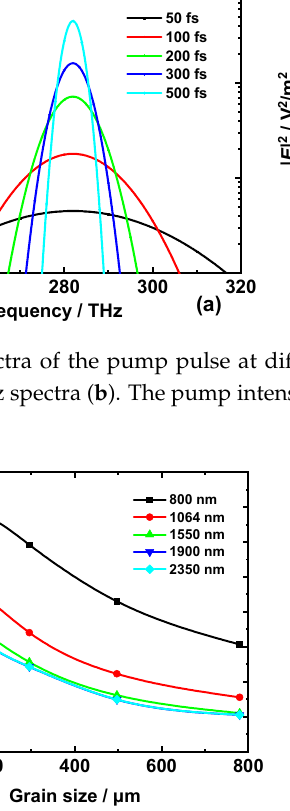
Figure 8. The spectra of the pump pulse at different pulse durations ( a ) and the corresponding gen- erated terahertz spectra ( b ). The pump intensity was 30 GW/cm 2 at 1064 nm.